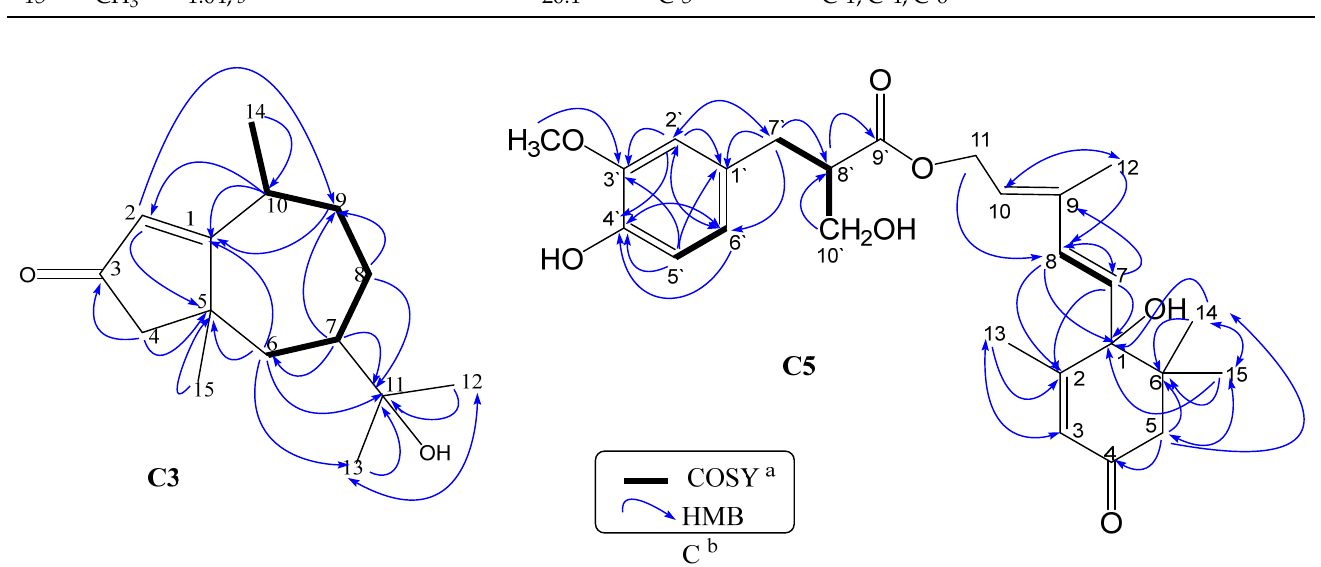
Figure 2. (a) Selected COSY correlations and (b) HMBC correlations of the new compounds ( C3 and Figure 2. ( a ) Selected COSY correlations and ( b ) HMBC correlations of the new compounds C5 ). ( C3 and C5